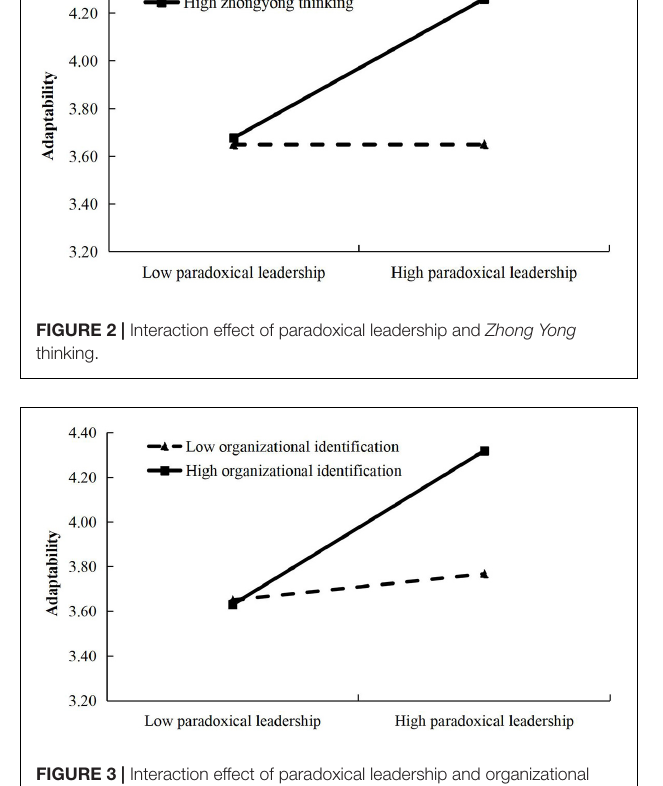
FIGURE 3 | Interaction effect of paradoxical leadership and organizational identification.